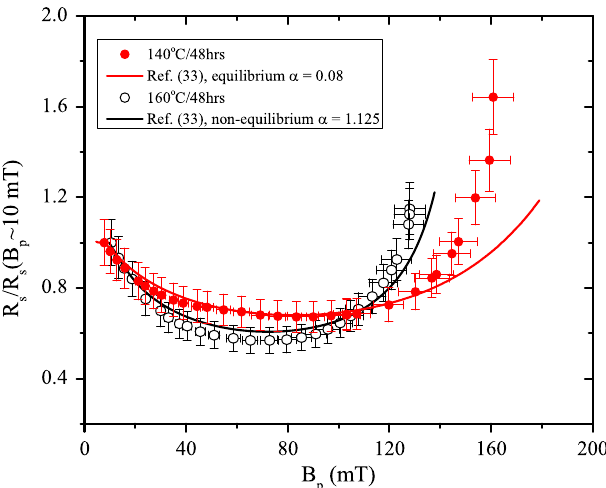
FIG. 10. R s =R s ð B p ∼ 10 mT Þ vs B p calculated using the model in Ref. [33] along with the experimental data for cavity heat treated at 140 and 160 °C,